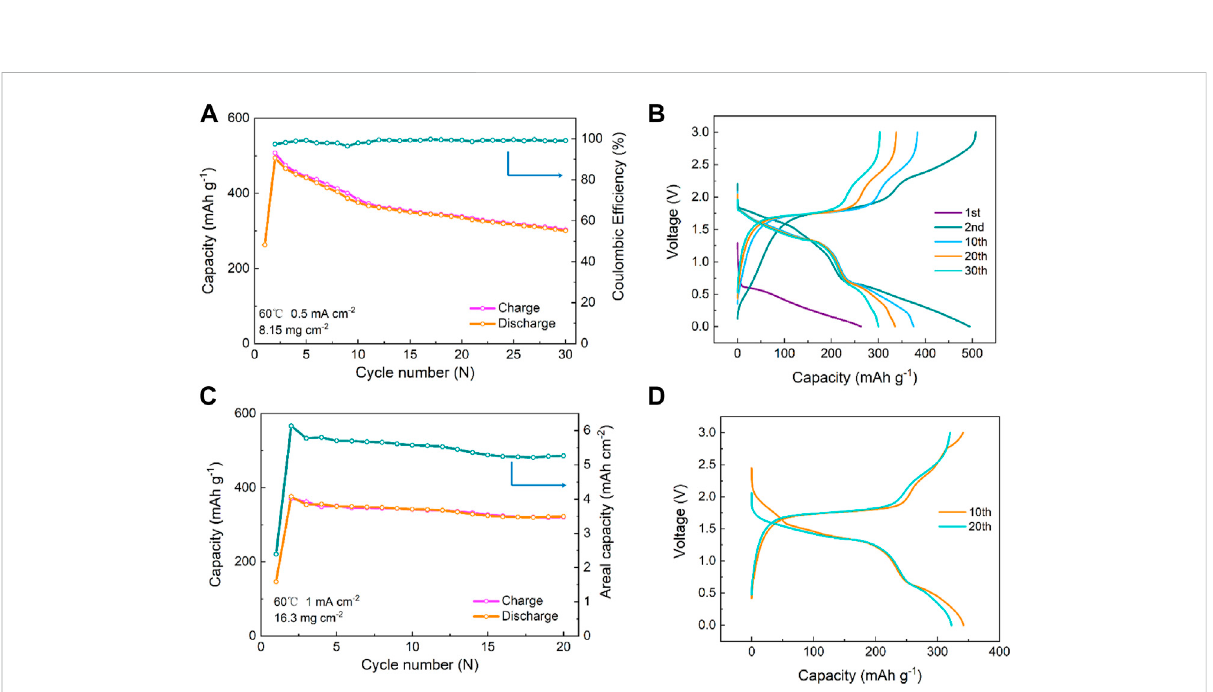
FIGURE 7 Cycling performance of the In/InLi | LPSB | LPSB-MWCNTs ASSBs at 60 ° C (A) with cathode LPSB loading of 8.15 mg cm − 2 at 0.5 mA cm − 2 and (C) with cathode LPSB loading of 16.3 mg cm − 2 at 1 mA cm − 2 and (B and D) the corresponding discharge – charge voltage pro fi les of the cells at different